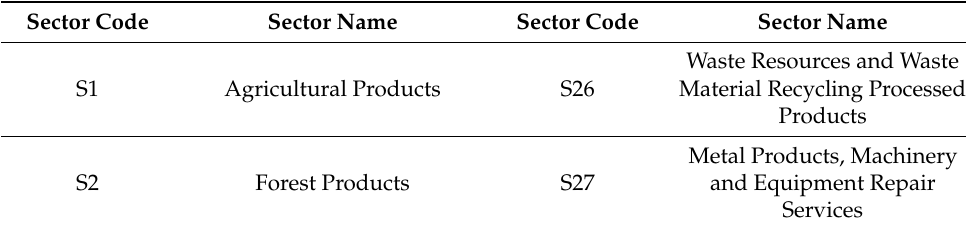
Table A2. Sectors in Zheng